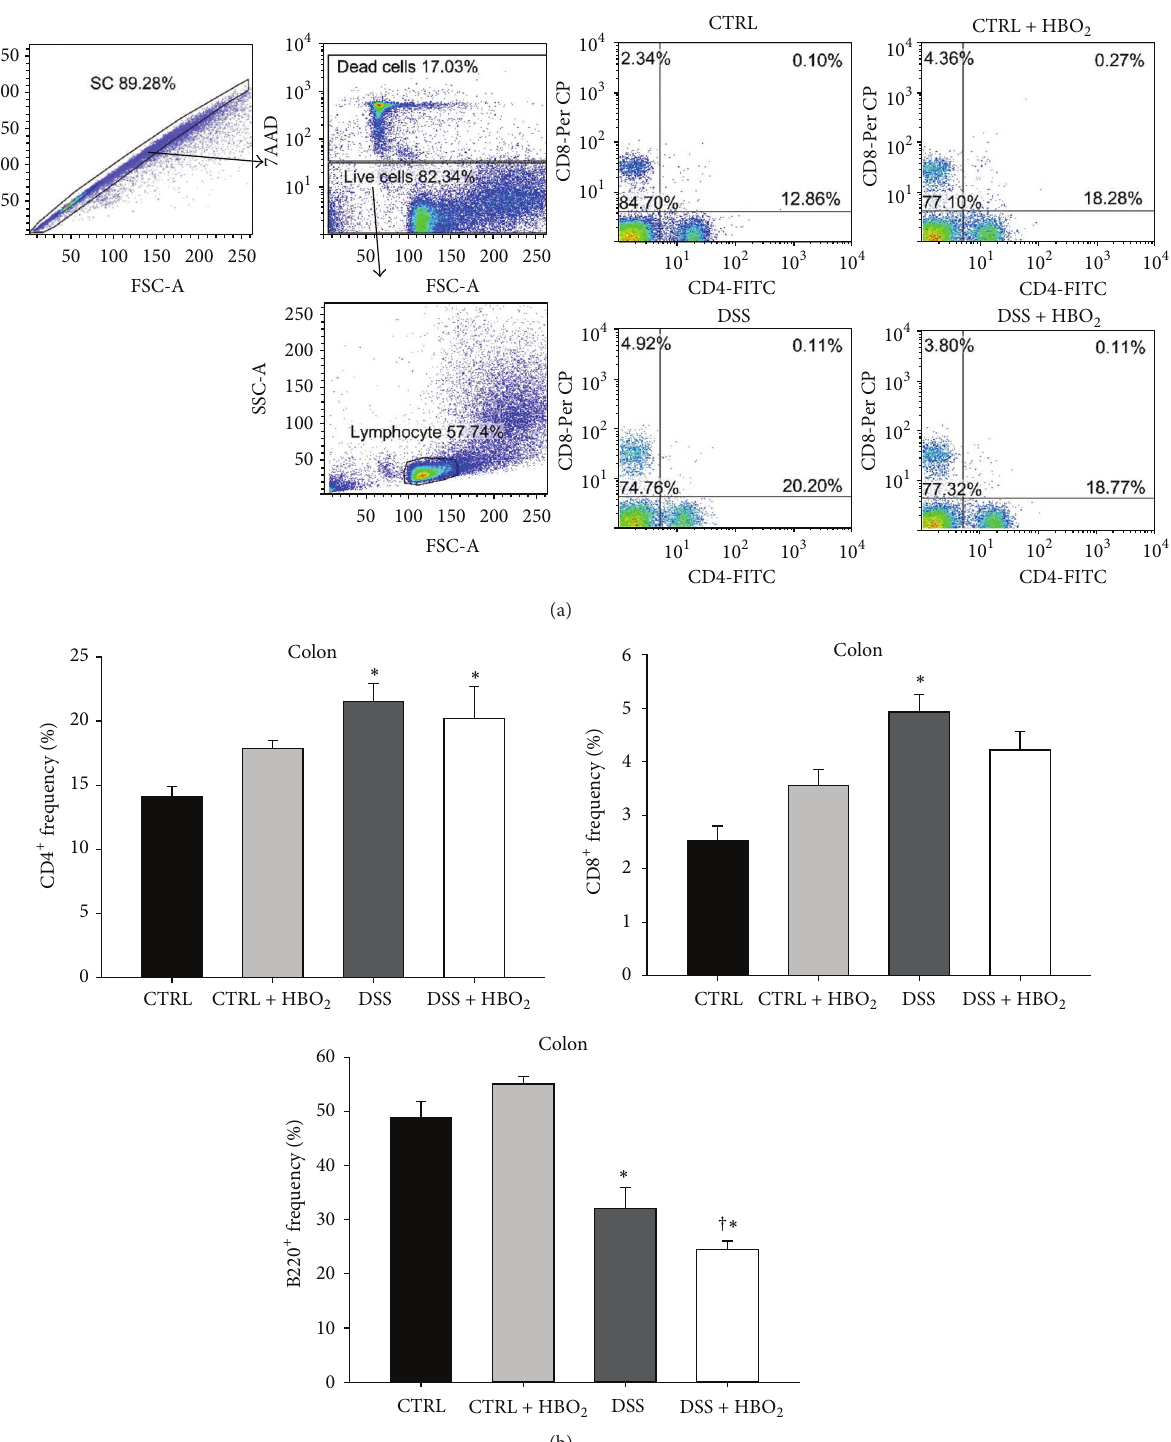
Figure 3: HBO 2 induced changes in CD4 + and CD8 + T cell frequencies in the colon of BALB/c mice with DSS induced colitis. BALB/c mice at the age of 10–12 weeks were randomly assigned into 4 groups ( 𝑛 = min. 4 mice/group/experiment): CTRL: control mice, CTRL + HBO 2 : control mice undergoing HBO 2 (60min/2.4 ATM, 2x/day, days 1–8), DSS: mice receiving dextran sodium sulphate (DSS, 5% w/v, days 1–7), and DSS + HBO 2 : DSS treated mice undergoing HBO 2 . (a) Representative dot plots of colon lamina propria lymphocyte obtained by flow cytometry, illustrating the gating strategy for CD4 + and CD8 + lymphocytes, and (b) measured frequencies of colon CD4 + and CD8 + lymphocytes. Doublets were excluded by forward scatter area (FSC-A) versus forward scatter height (FSC-H) and the dead cells using 7-AAD. Data are presented as mean ± s.e.m.% of single, live lymphocytes. ∗ Statistically different from CTRL, 𝑃 < 0.05 ; † statistically different from CTRL + HBO 2